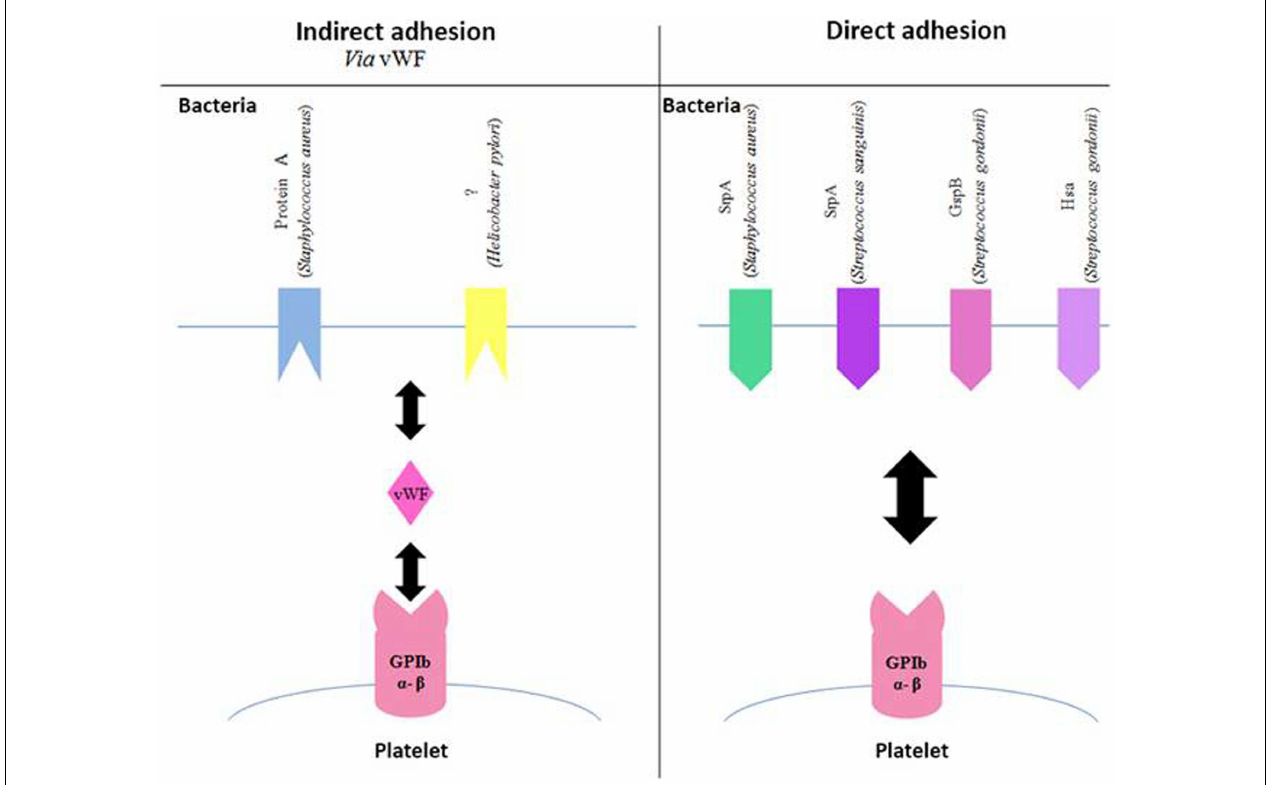
of the diagram) or directly (right side of the diagram). Gsp, glycosylated streptococcal protein; Srp, serine-rich protein; Hsa, sialic acid-binding